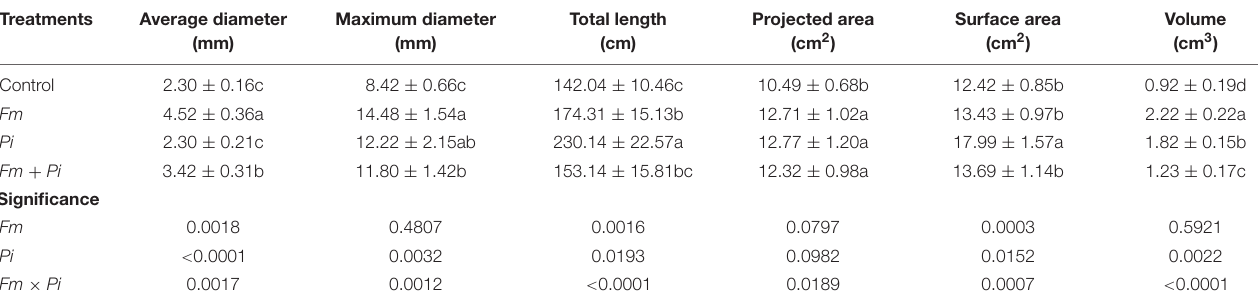
TABLE 3 | Effects of Funneliformis mosseae ( Fm ) and Piriformospora indica ( Pi ) single or in combination on root morphology of Polygonum cuspidatum Sieb. et Zucc.